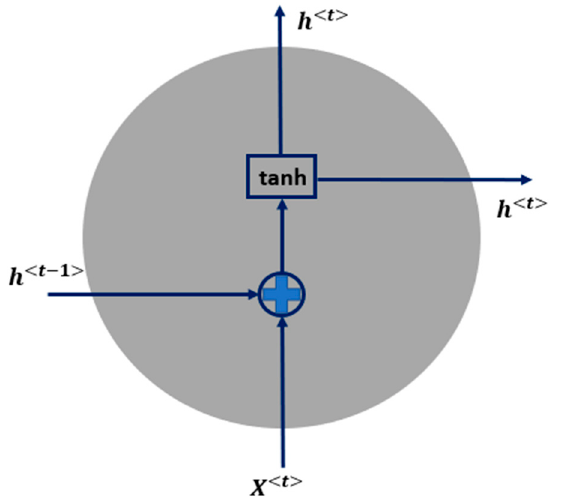
Figure 2. Illustration of simple RNN unit, having a simple structure without